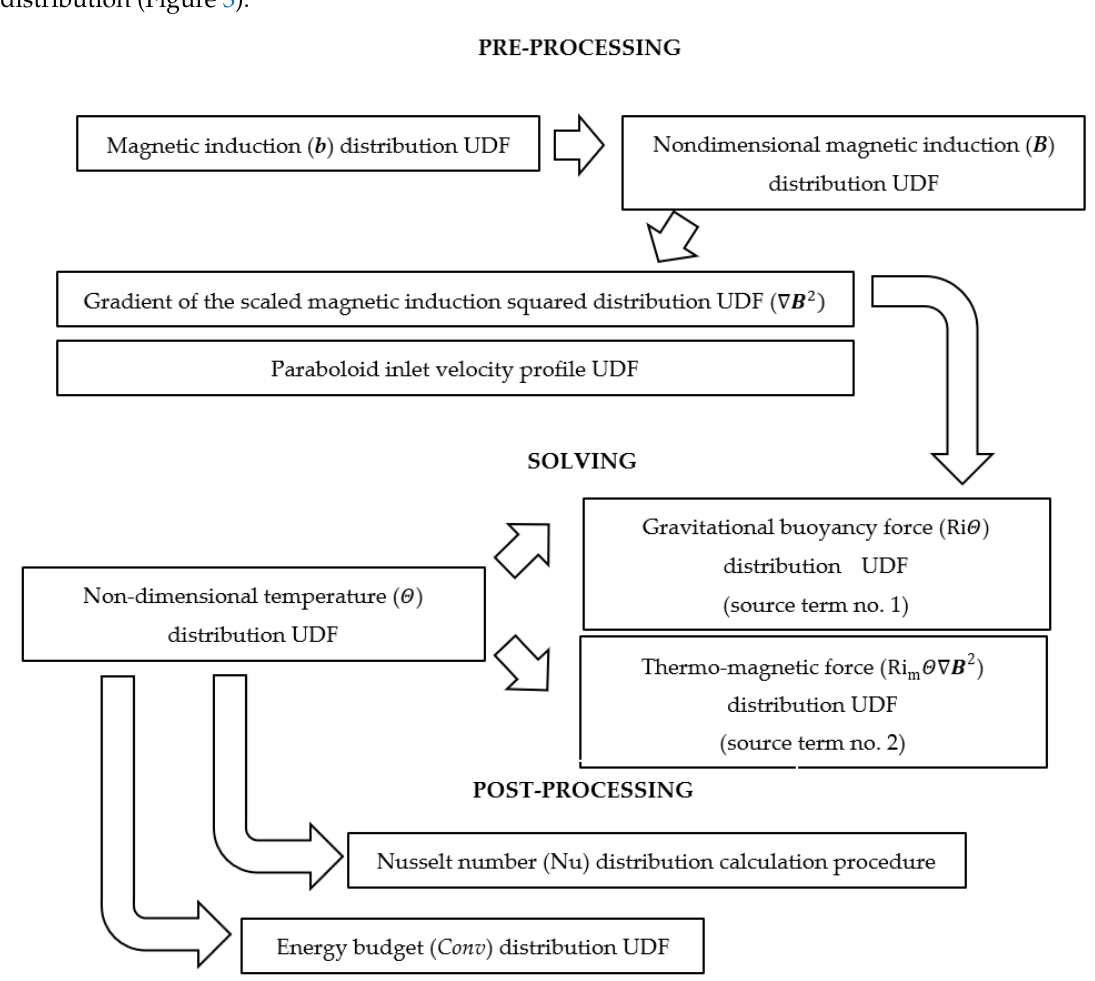
Figure 3. User-defined functions implementation scheme.